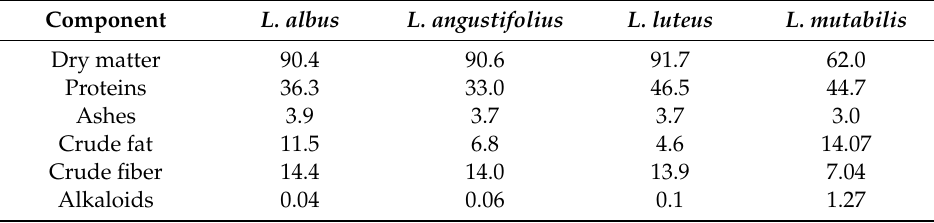
Table 1. Chemical composition and alkaloids in the seeds of four lupine species (g/100 g DM).